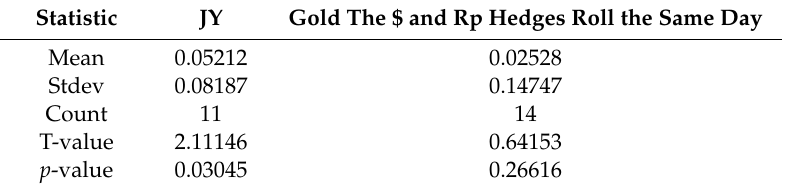
Table A6. $ (low c) h T − Rp (high c) h T .